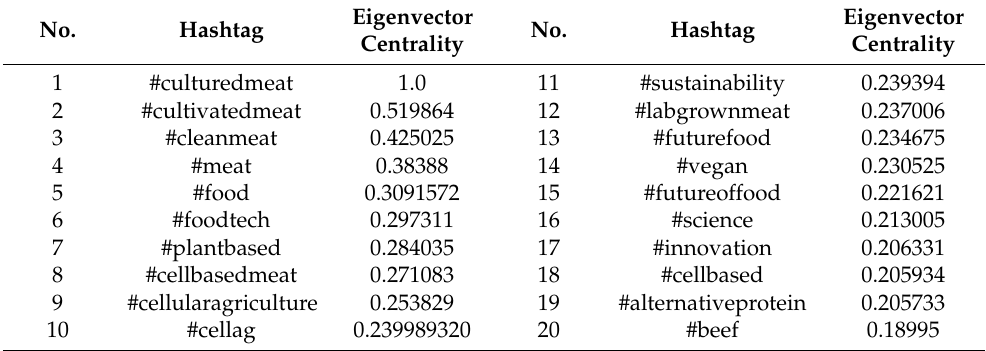
Table 2. Eigenvector centrality values of the top 20 hashtags published in connection with cultured meat on the social network